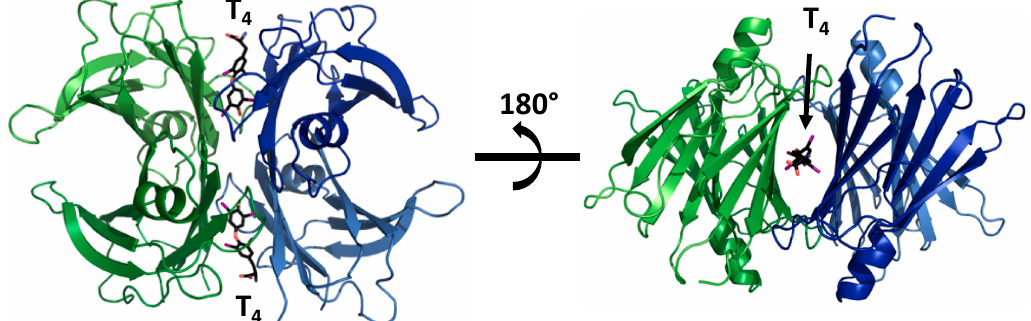
Figure 1. Structural model of transthyretin (TTR) complexed with T 4 (PDB 2rox). Upon forming a tetrameric complex, TTR constitutes two hydrophobic binding pockets, which are occupied by two T 4 molecules in this model.